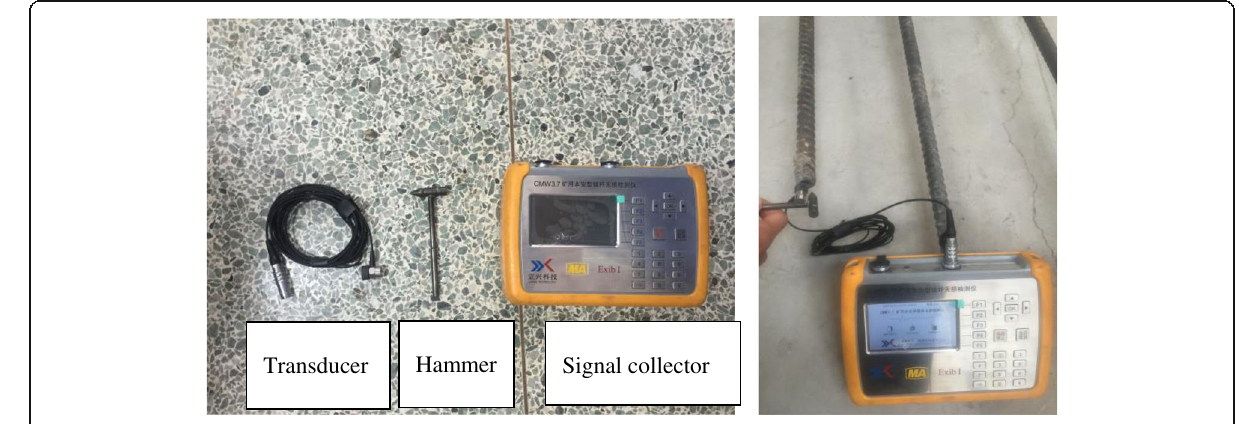
Fig. 5 The diagram of the test